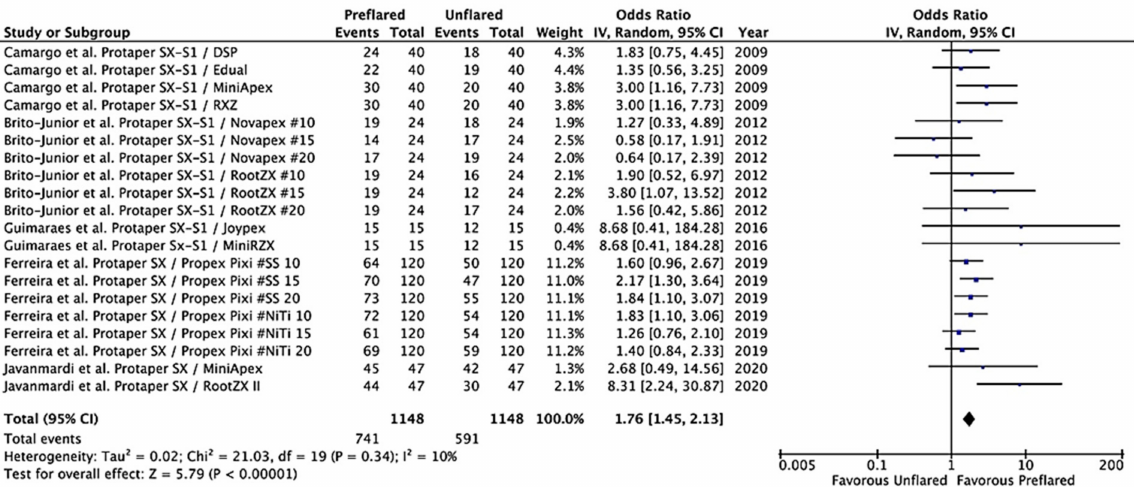
Figure 5. Forest plot of ORs and 95% confidence limits (CL) for the comparison of unflared and preflared canals using Protaper SX and S1 files regarding the accuracy of EALs in working length (WL) determination. The overall estimate is based on the data from the seven included studies. Black squares represent the point estimate of the odds ratio and have areas proportional to study size. Lines represent 95% confidence intervals. The diamond shows the summary statistic for the 20 results from the five included studies. The solid line indicates an odds ratio of 1.0. OR: odds